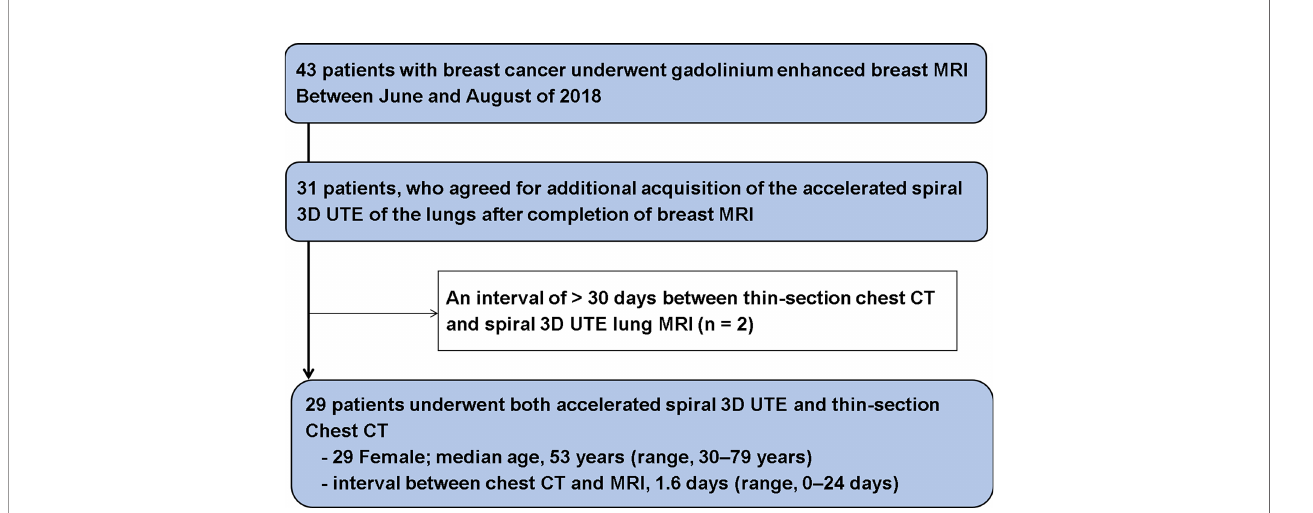
FIGURE 1 | Flow chart of patient